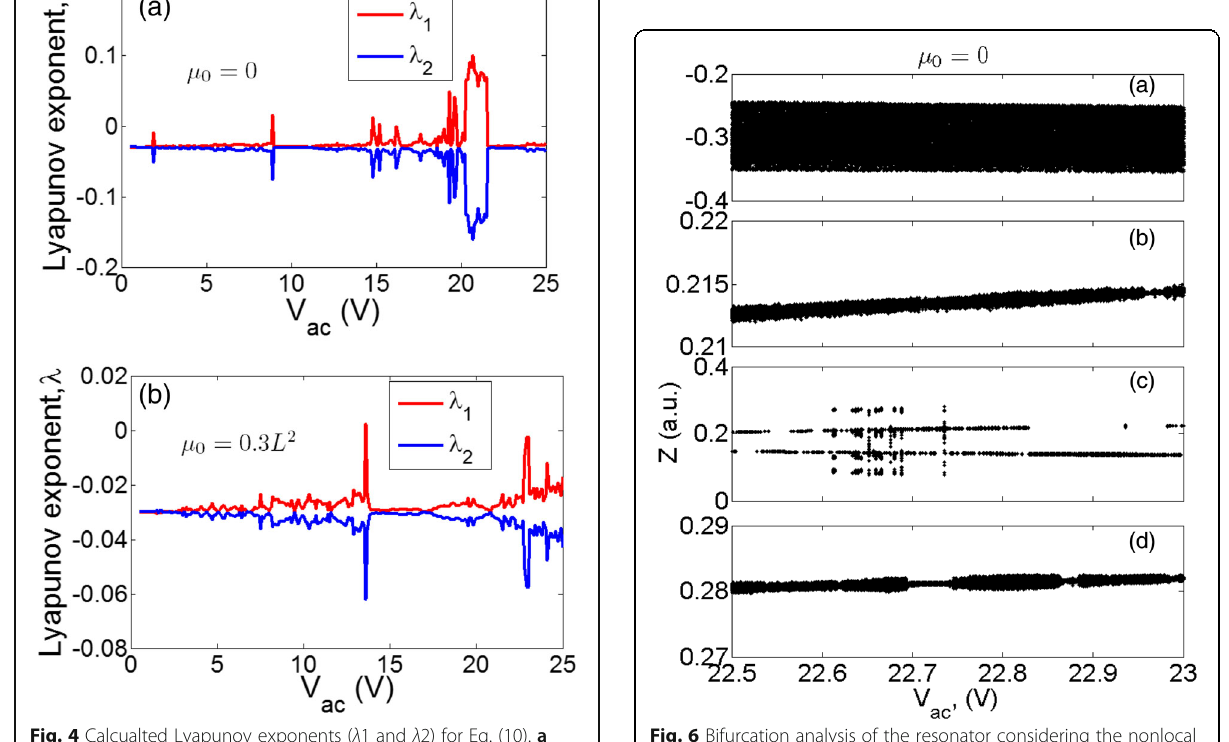
Fig. 6 Bifurcation analysis of the resonator considering the nonlocal effect. The frequency ratio ω / ω 0 is 0.8 ( a ), 1 ( b ), 1.1 ( c ), and 1.2 ( d